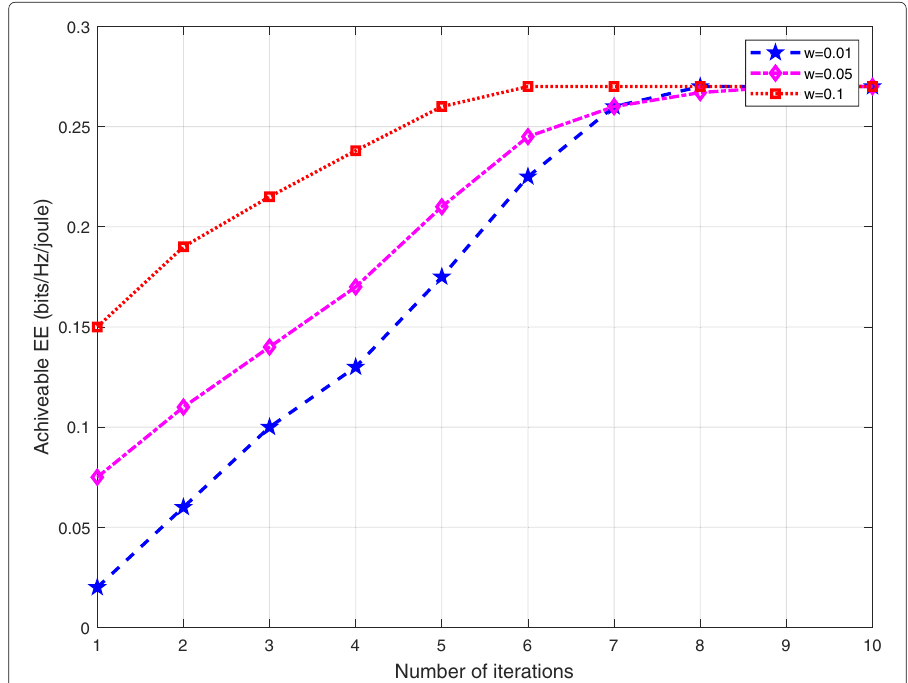
Fig. 2 The convergence analysis result of the proposed